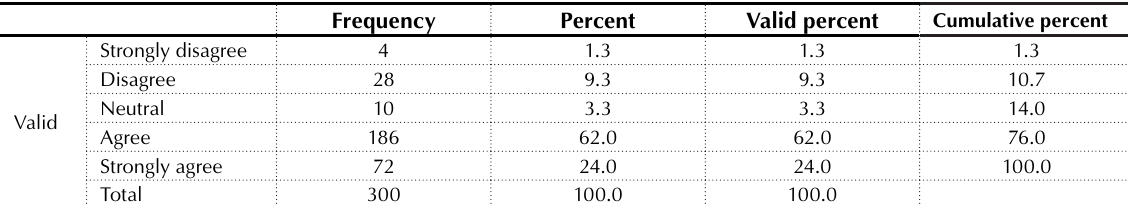
Table 1. Services rendered by this CSC were of an acceptable